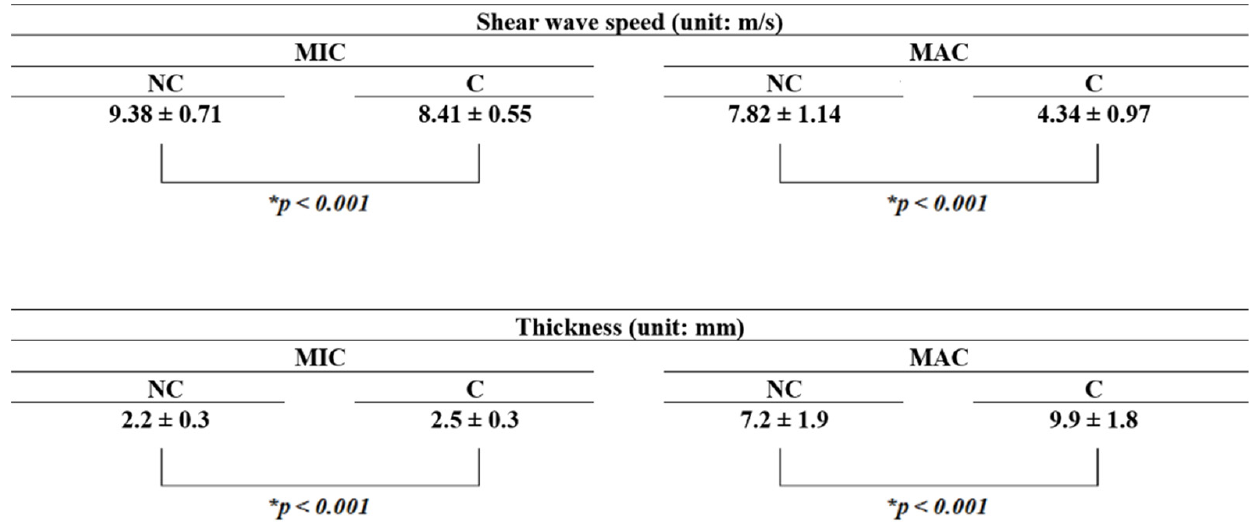
Figure 6. The statistical results. For both the microchamber (MIC) and macrochamber (MAC) layers of the heel pad, the shear wave speed decreased and thickness increased significantly with a plastic heel cup (C) compared with the condition without a plastic heel cup (NC). The asterisk symbol indicates a statistically significant difference.